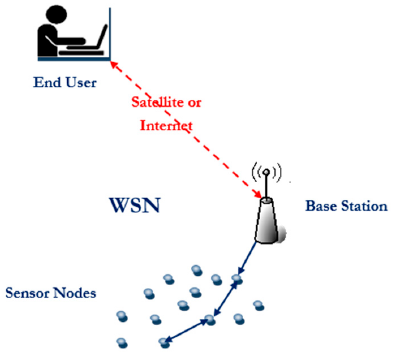
Figure 2. The typical architecture of a WSN.